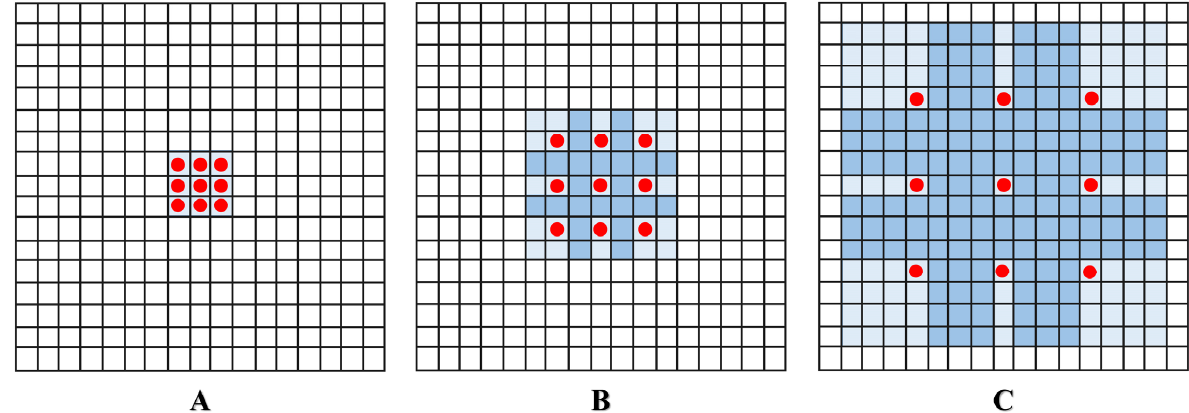
Figure 3. Conceptual graph of atrous convolution. ( A ) The 1 ‐ dilated conv of 3 × 3; ( B ) the 2 ‐ dilated conv of 3 × 3; ( C ) the 4 ‐ dilated conv of 3 × 3.